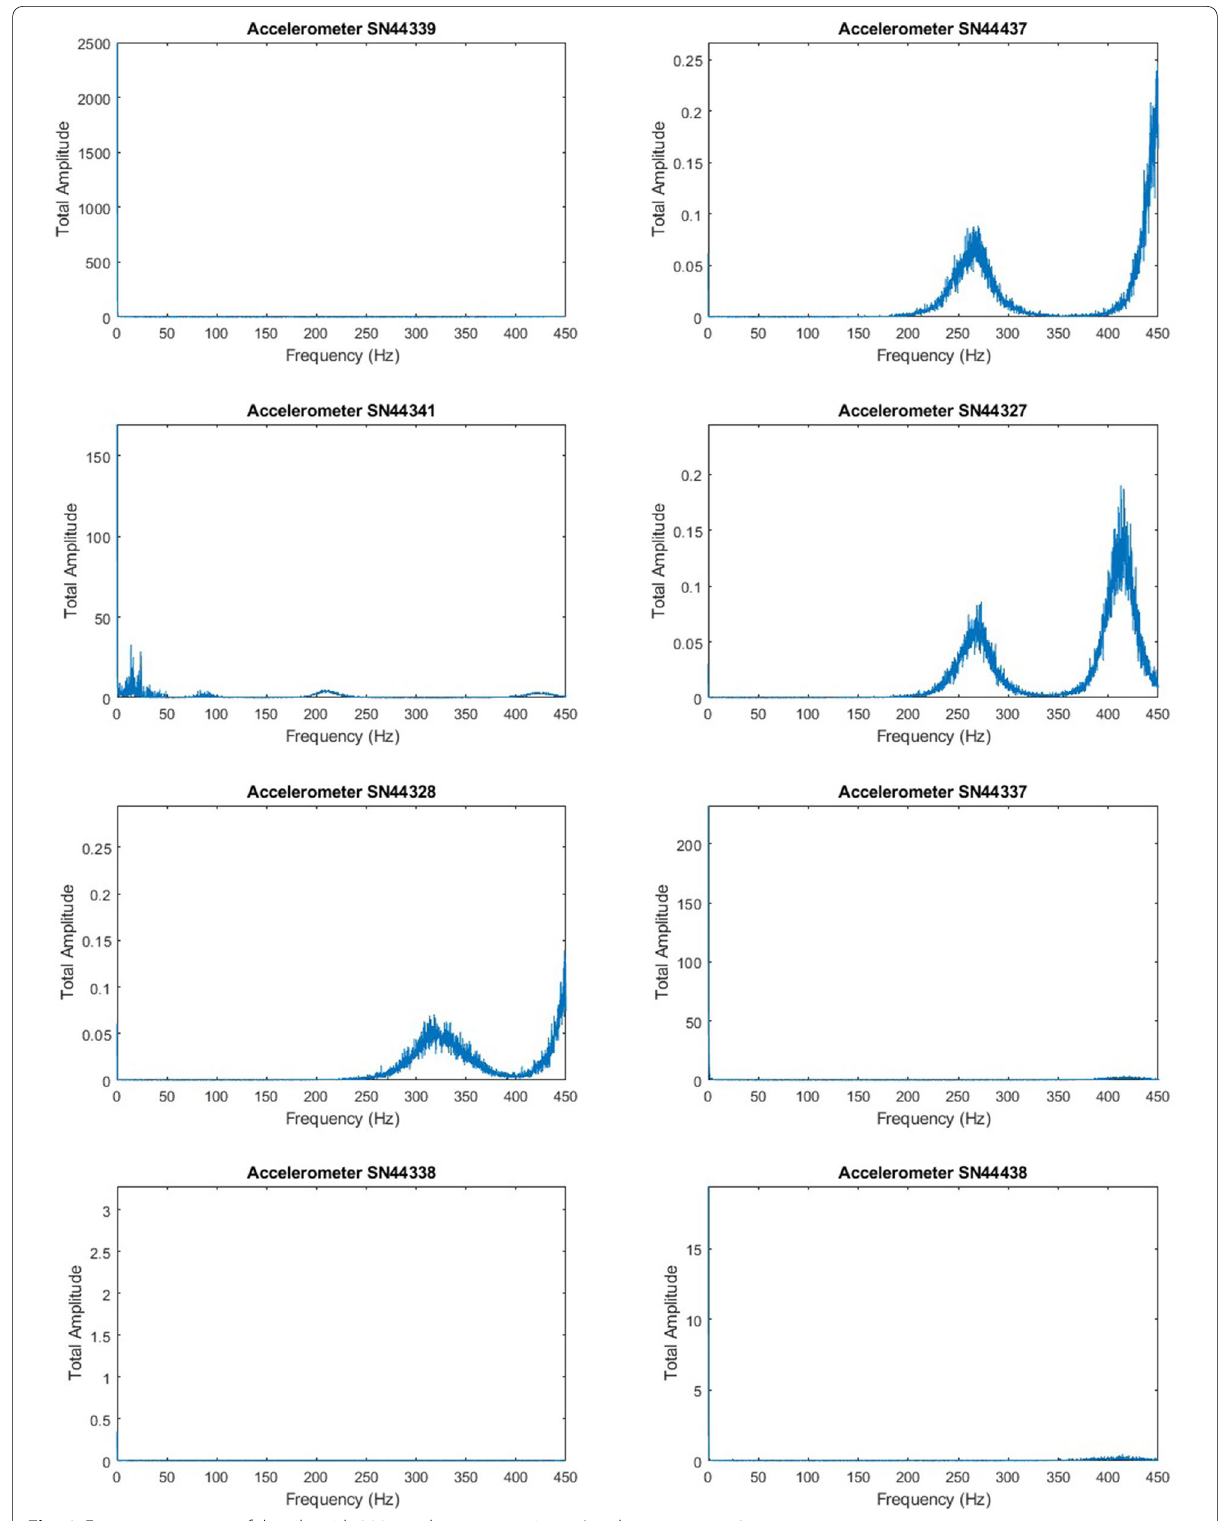
Fig. 6 Frequency spectra of the silo with 300 mm hopper opening – Accelerometer 1 to